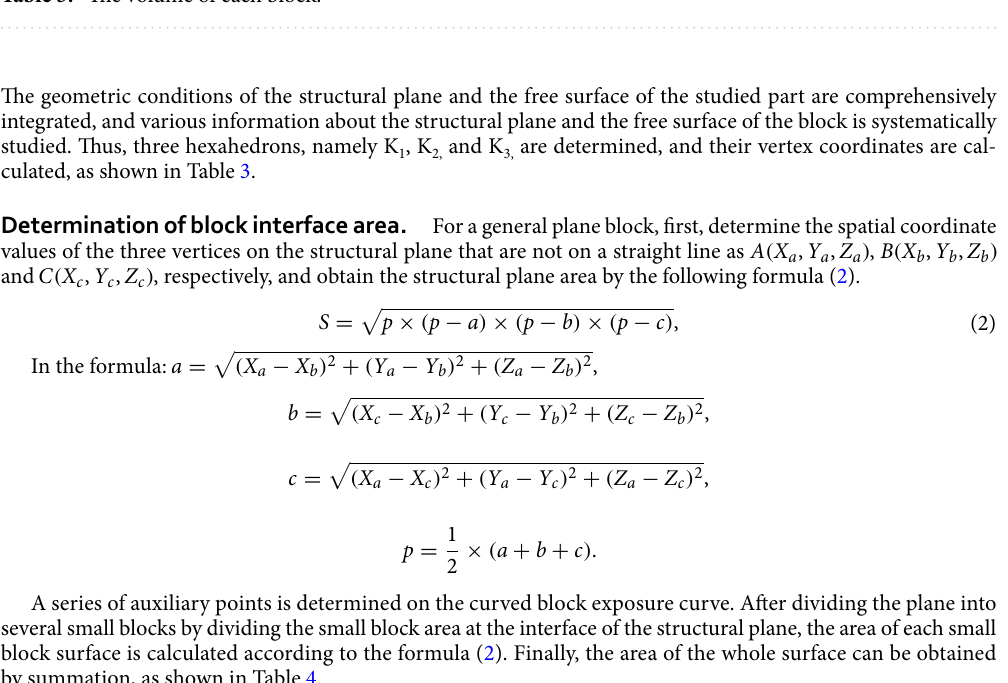
Table 5. The volume of each